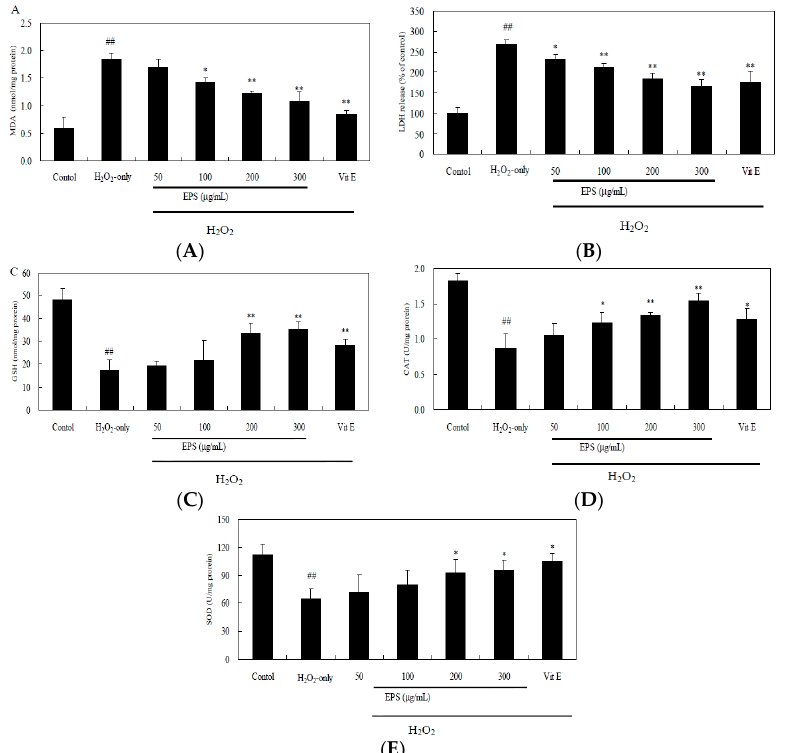
Figure 9. Effect of EPS on MDA ( A ); LDH ( B ); intracellular GSH level ( C ); CAT ( D ) and SOD ( E ) activity in PC12 cells. Cells were pretreated with 50–300 μ g/mL EPS or 500 μ M vitamin E (Vit E) for 24 h and